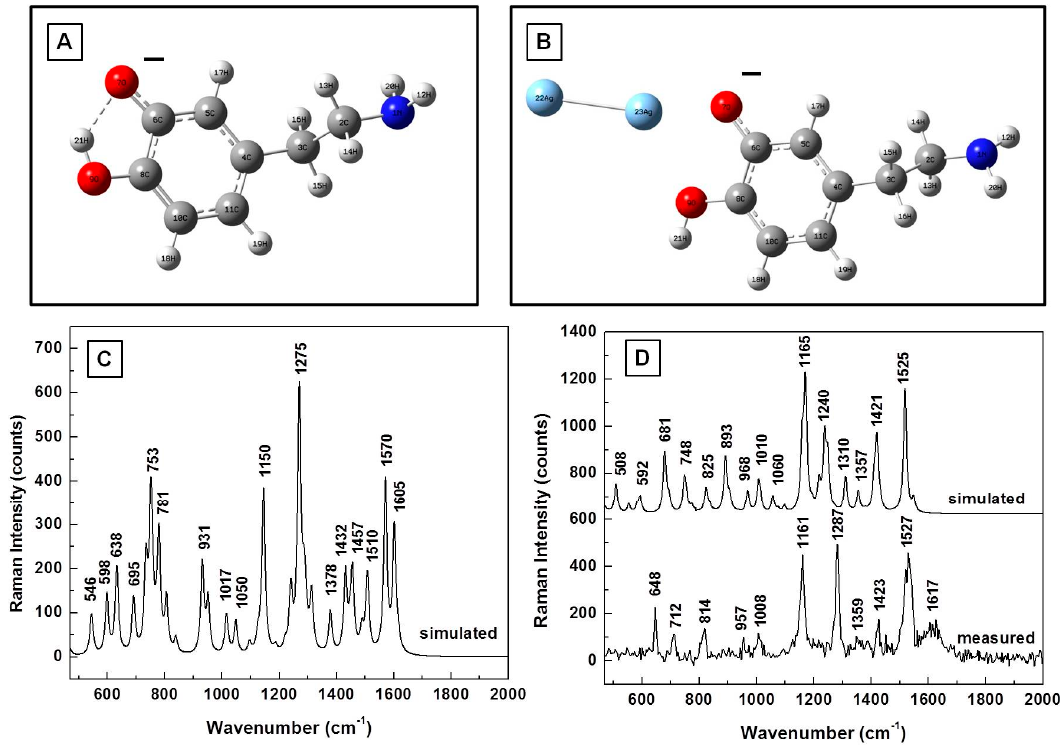
Figure 4. ( A , B ) Structural representations of the anionic form of dopamine without and with the silver dimer, respectively; ( C ) Theoretically calculated Raman vibrations of DA − ; and ( D ) Theoretically calculated and experimentally measured Raman vibrations of the anionic form in the proximity of silver. The spectra are vertically translated for easier visualization and appropriately labeled.